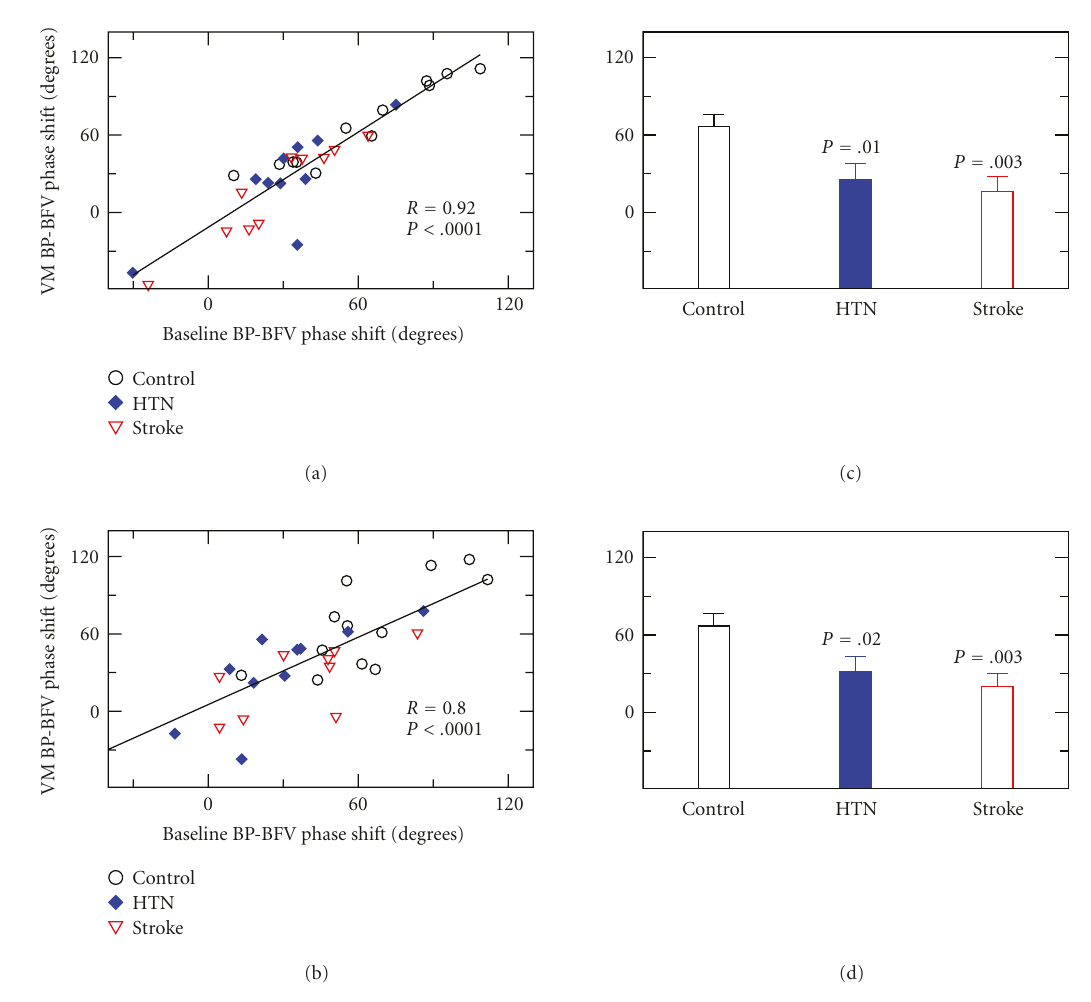
Figure 5: Comparison of the BP-BFV phase shift during two di ff erent conditions and between control, hypertensive (HTN), and stroke groups. (a)-(b) (adapted from [15]). For each subject in this study, BP-BFV phase shifts for left (a) and right (b) side middle cerebral arteries (MCAs) were measured during the Valsalva maneuver (VM) and during supine baseline conditions. The straight line is the linear regression fit of the data. The phase shifts during VM and baseline showed a strong correlation (left R = 0 . 92, P < . 0001; right R = 0 . 8, P < . 0001). (c)-(d). BP-BFV phase shifts during VM were smaller in hypertensive and stroke groups than in control group in both left and right MCAs (HTN: left P = . 01, right P = . 02; Stroke: left P = . 003, right P = .